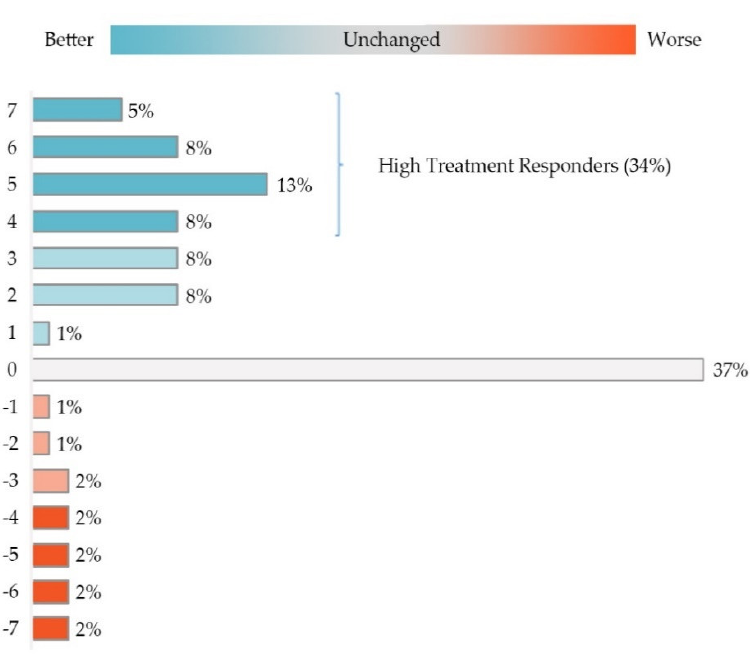
Figure 2. The majority of participants (51%) reported some improvement in their condition after treatment with antibiotics, with High Treatment Responders constituting 34% of participants. Approximately 37% reported their condition as unchanged. Only 12% reported their condition as worse. Slight deviation in the percentages in the figure from the text reflect rounding errors.